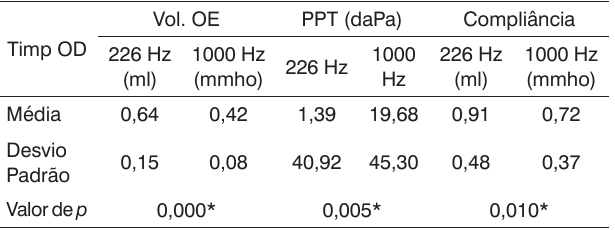
Tabela 1. Medidas dos valores da timpanometria com sonda de 226 Hz e 1000 Hz na